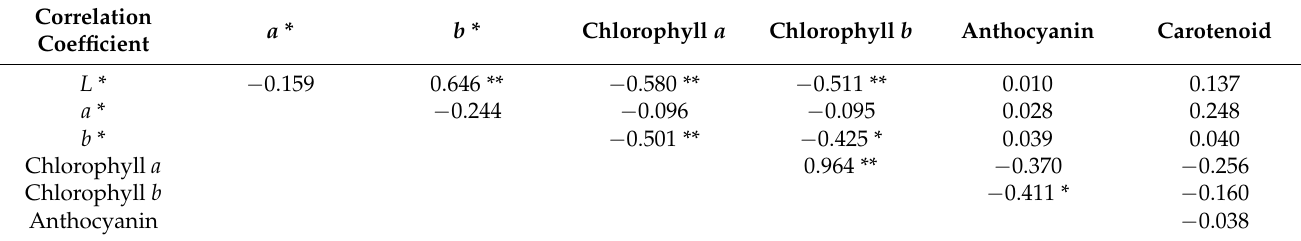
Table 5. Correlation analysis between the leaf color and leaf pigment contents in this study.